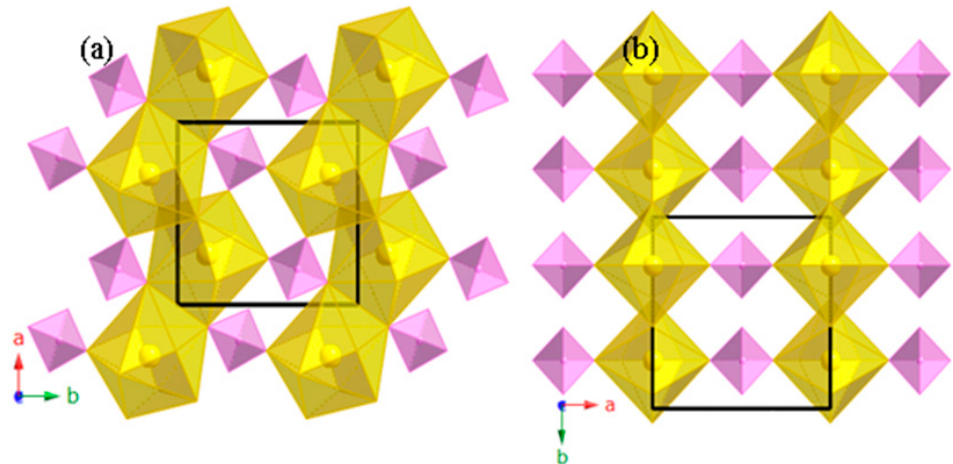
Figure 1. The structures of ( a ) monazite (space group P 2 1 / n ) and ( b ) xenotime (space group I 4 1 / amd ) projected down [001] with unit cells outlined in black. The two structures are similar and the transition from monazite to xenotime results in a more symmetrical structure. Rotation of the PO 4 tetrahedra (purple) in ( a ) gives rise to more symmetrical features in ( b ). Polyhedra AO 9 in ( a ) and AO 8 in ( b ) are shown in yellow.